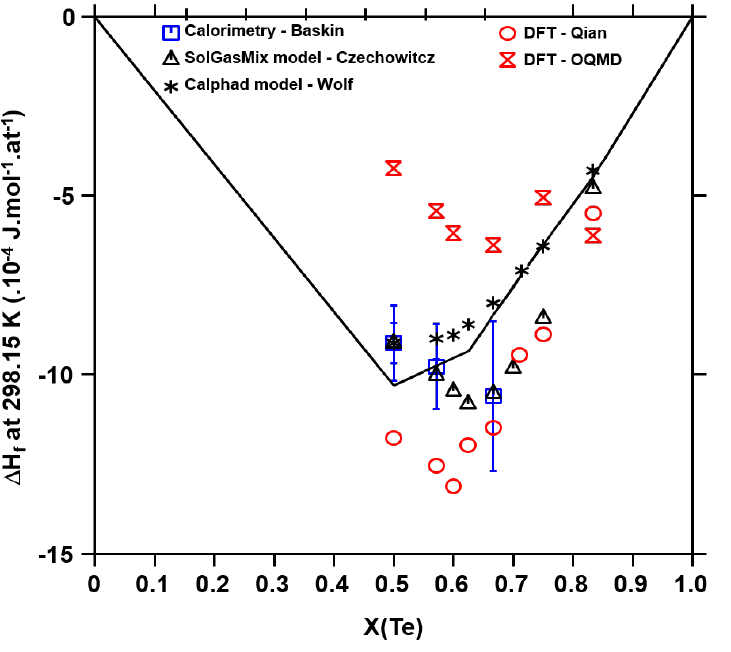
Figure 4. Calculated enthalpy of formation of UTe, U 3 Te 4 , U 2 Te 3 , U 3 Te 5 , UTe 2 , U 2 Te 5 , UTe 3 , and UTe 5 . Comparison with the experimental data from Baskin et al. [23], the models from Czechowitz [19] and Wolf [20], and the DFT calculations from Qian [25] and the OQMD database [26].